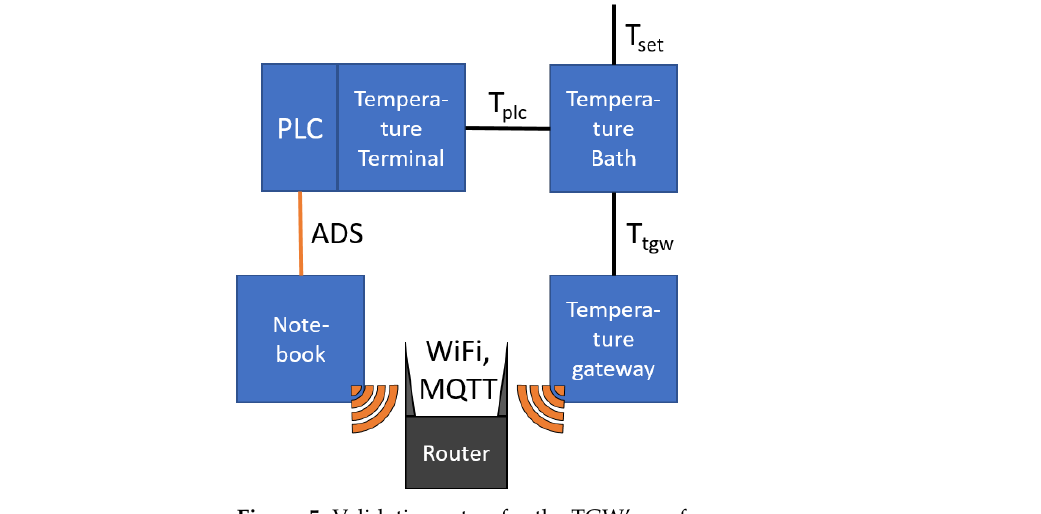
Figure 5. Validation setup for the TGW’s performance.